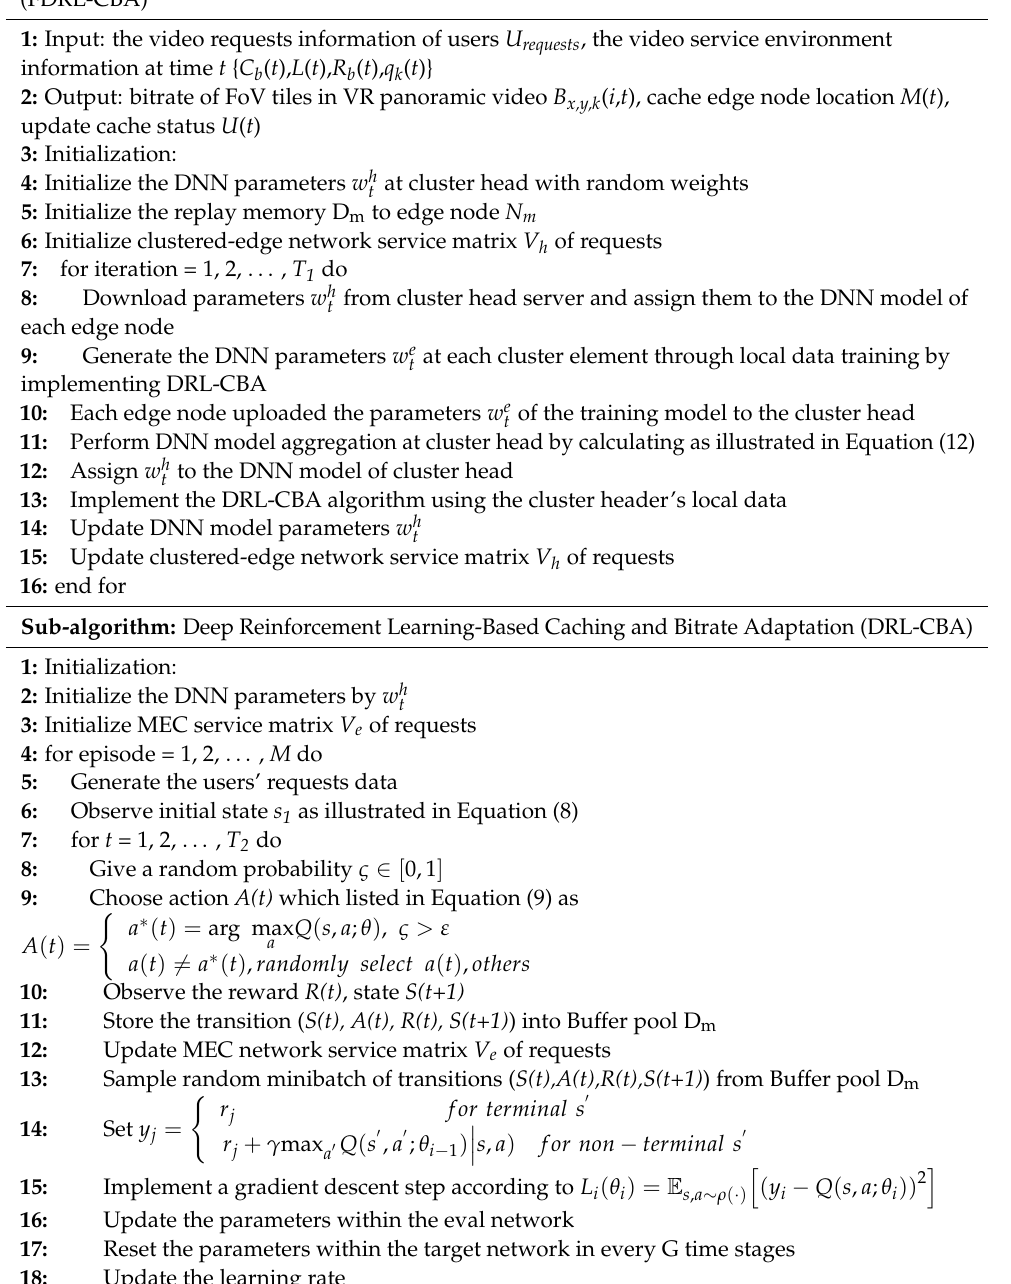
Algorithm 1: Federated Deep Reinforcement Learning-Based Caching and Bitrate